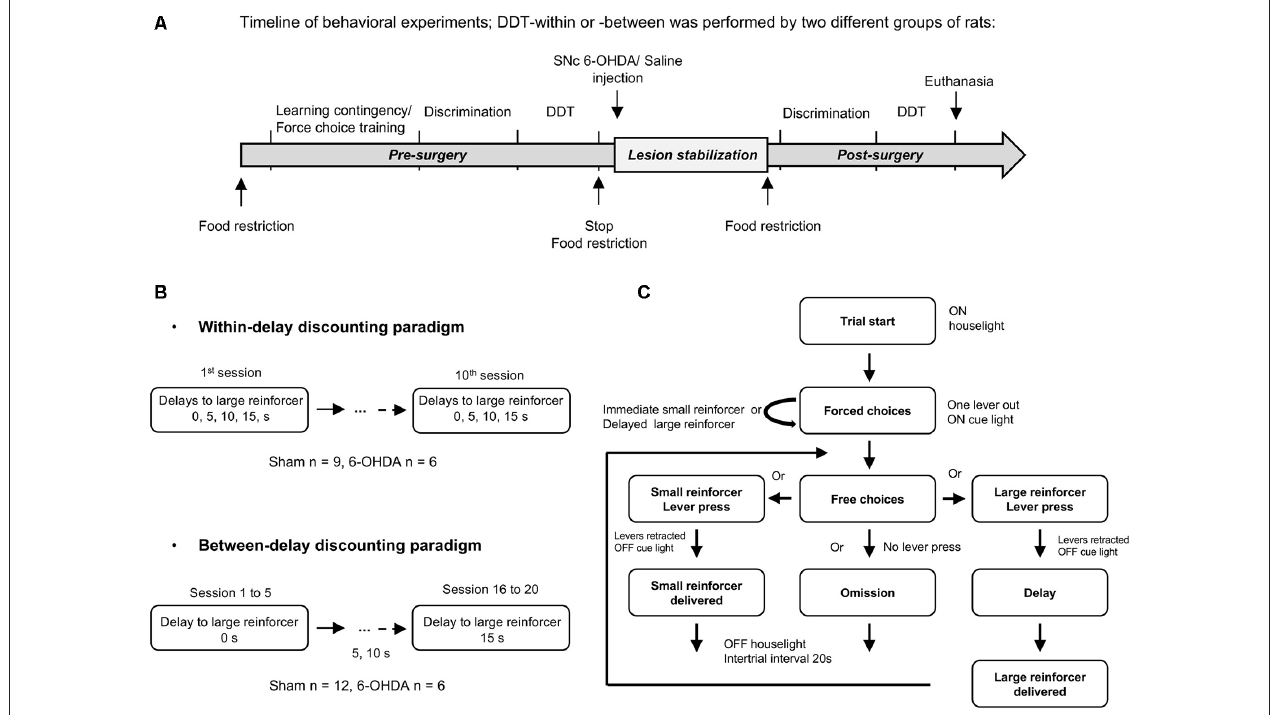
FIGURE 1 | Delay Discounting Task (DDT) paradigms. (A) Experimental schedule and timeline of the experiments. Training in DDTs was performed prior to, and after, intra-substantia nigra pars compacta (SNc) 6-hydroxydopamine (6-OHDA)/saline injection. The two experimental groups of rats followed the same timeline at the exception that they were tested either in a DDT-within or DDT-between procedure. (B) Flow chart of delay discounting blocks. Each block starts with forced choices wherein only one lever is extended at the time in a random order, allowing rats to learn or recall the contingency of that lever (small or large reinforcer; i.e., 120 µ L of a 5% or 10% sucrose solution, respectively) and the delay associated with. Then, rats have free choices access to the small or large reinforcer (both levers are extended), associated with the delay experienced during forced choice trials. No lever press during 35 s of light on period leads to an omission and no reinforcer is delivered. After 35 s, the houselight is turned off and levers are retracted, for a 20 s intertrial interval (ITI), until the beginning of a new trial. During the task, each lever press leads also to levers retraction. (C) Schematic representation of the two DDT paradigms. The within-session delay discounting paradigm (within-DDT),